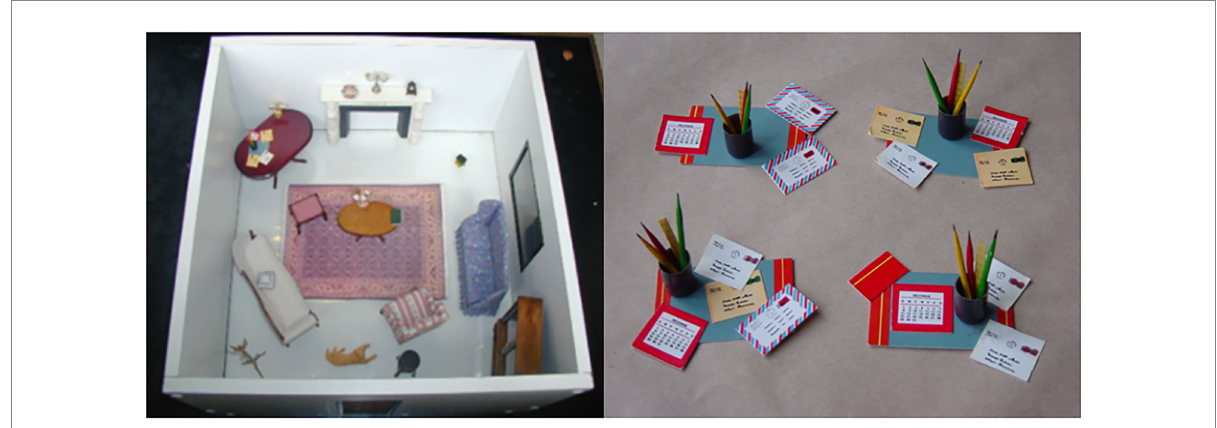
FIGURE 1 The target items from the WWW-T, as presented to participants, together with the four same-name alternative versions of the “desk-set” used in the visual recognition (figurative detail—Which) subtests of the 3-D WWW-T. Reproduced with permission from Dr. Colin Gallagher and Prof. Teresa